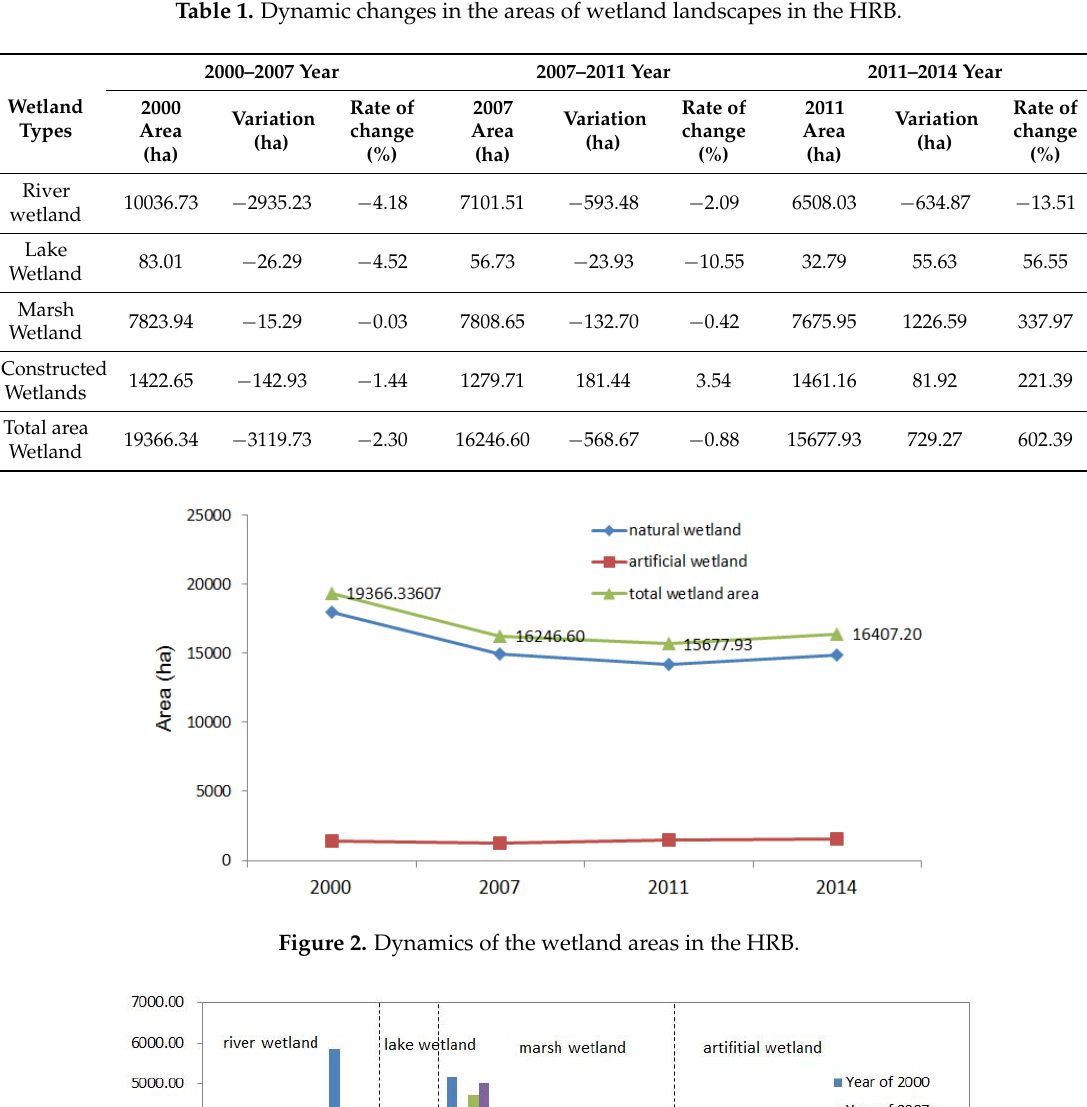
Table 1. Dynamic changes in the areas of wetland landscapes in the HRB.